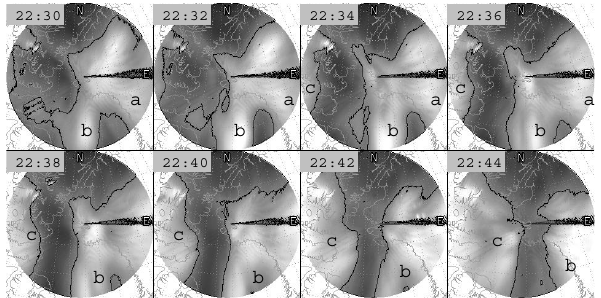
Fig. 4. A sequence of 630.0nm all-sky optical images for the period 22:30 to 22:44UT on 30 October 2003, mapped to geographic coor- dinates using an assumed emission altitude of 250km. Images were collected every 2min from Qaanaaq, Greenland (77.5 ◦ N, 69 ◦ W).